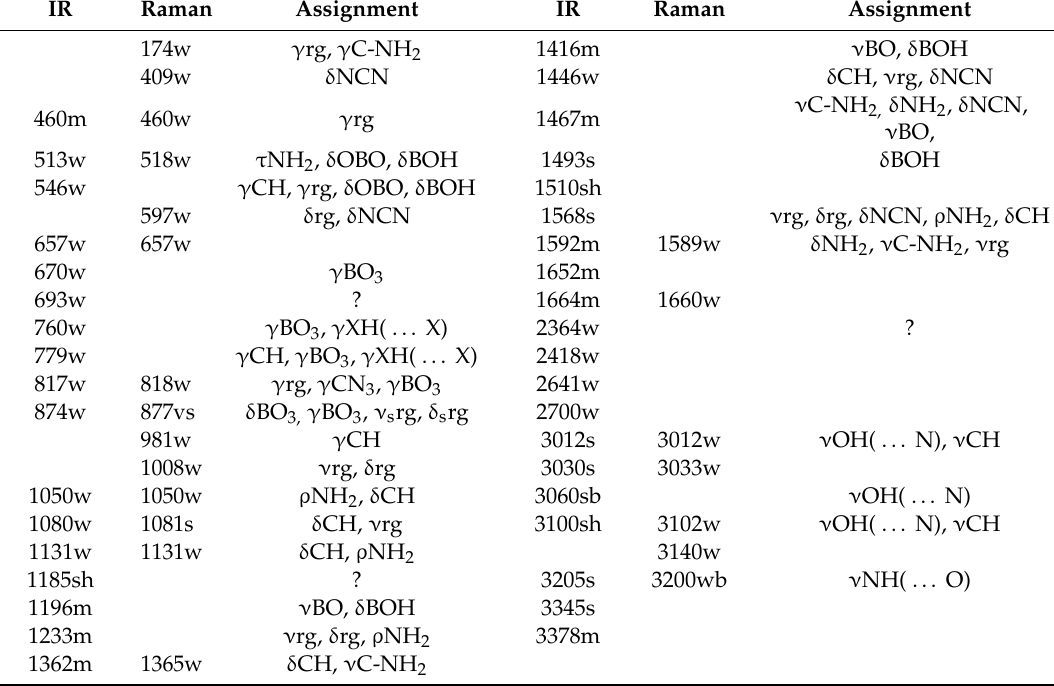
Figure 8. FTIR (compiled from nujol and fluorolube mulls) and FT Raman spectra of 2-AMP(H 3 BO 3 ) 2 . Table 3. Recorded FTIR and FT Raman maxima (cm − 1 ) of (2-AMP) 3 (H 3 BO 3 ) 2 and their assignment. Characteristic broadening and intensity increase of the IR-active bands of ν BO and δ BOH modes (1550–1370 cm –1 region) and γ BO 3 modes (850–650 cm –1 region) is likely related to the existence of O–H…O hydrogen bonds interconnecting boric acid molecules in AMP(H 3 BO 3 ) 2 . This